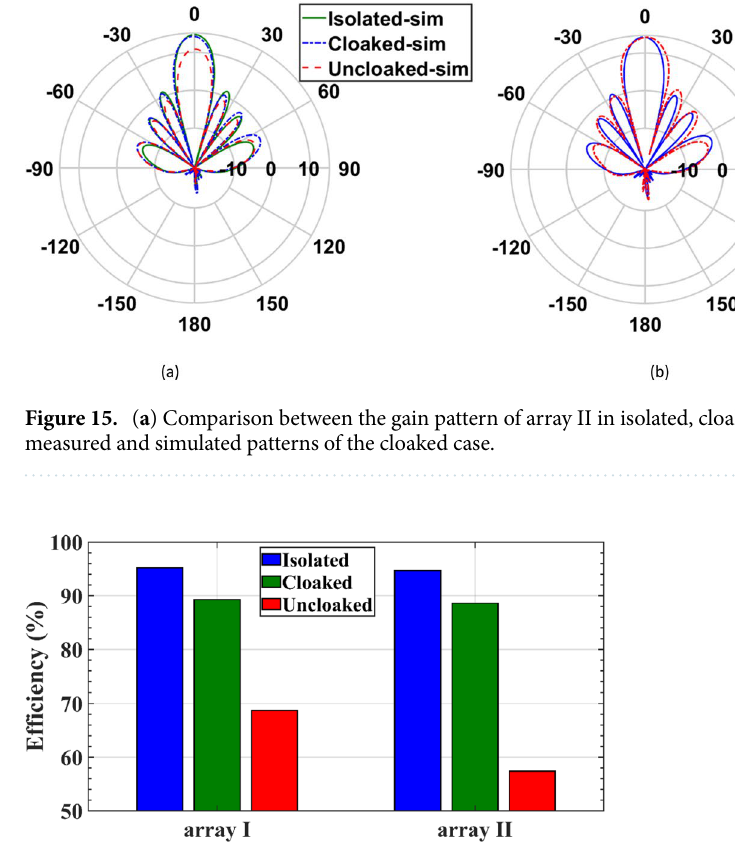
Figure 16. The total efficiency of the arrays I and II for three investigated